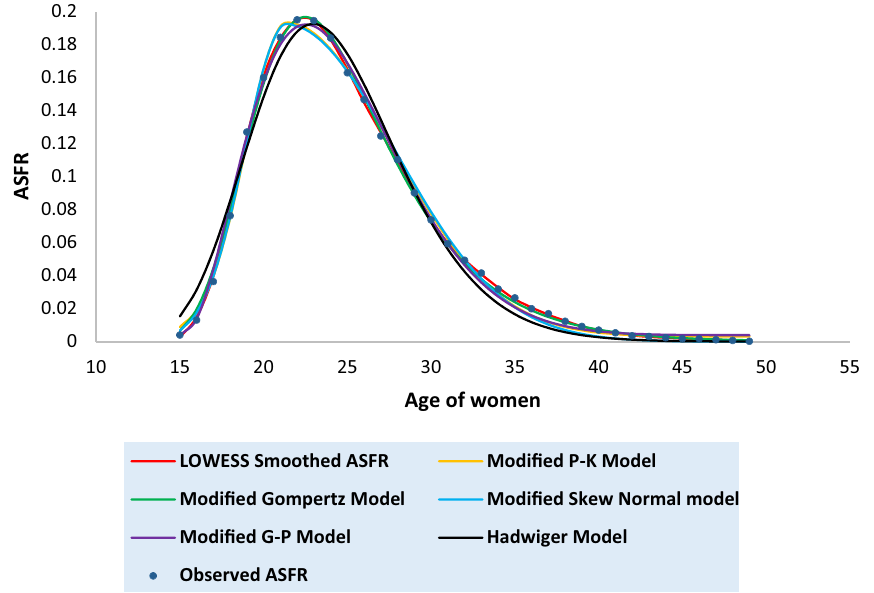
Figure 3. Observed and expected age-specific fertility rate (ASFR) for India under different proposed models and Hadwiger model.